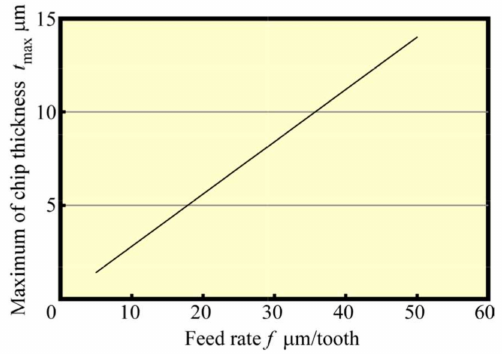
Figure 9. Relationship between maximum chip thickness and feed rate ( N s = 100,000 min − 1 ).